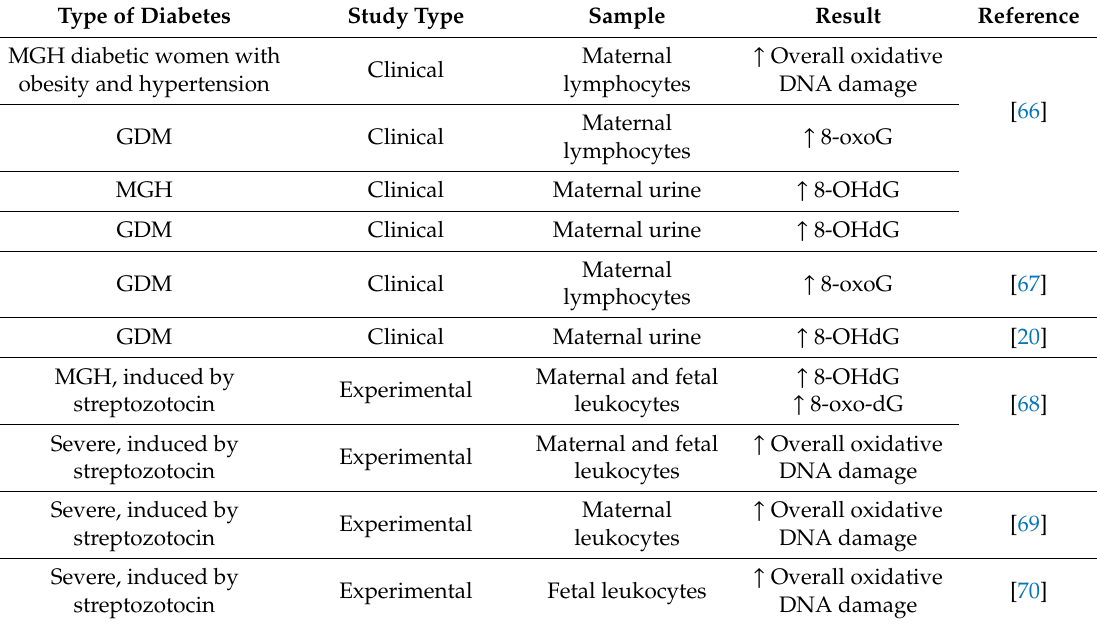
Table 1. DNA damage in hyperglycemic state during